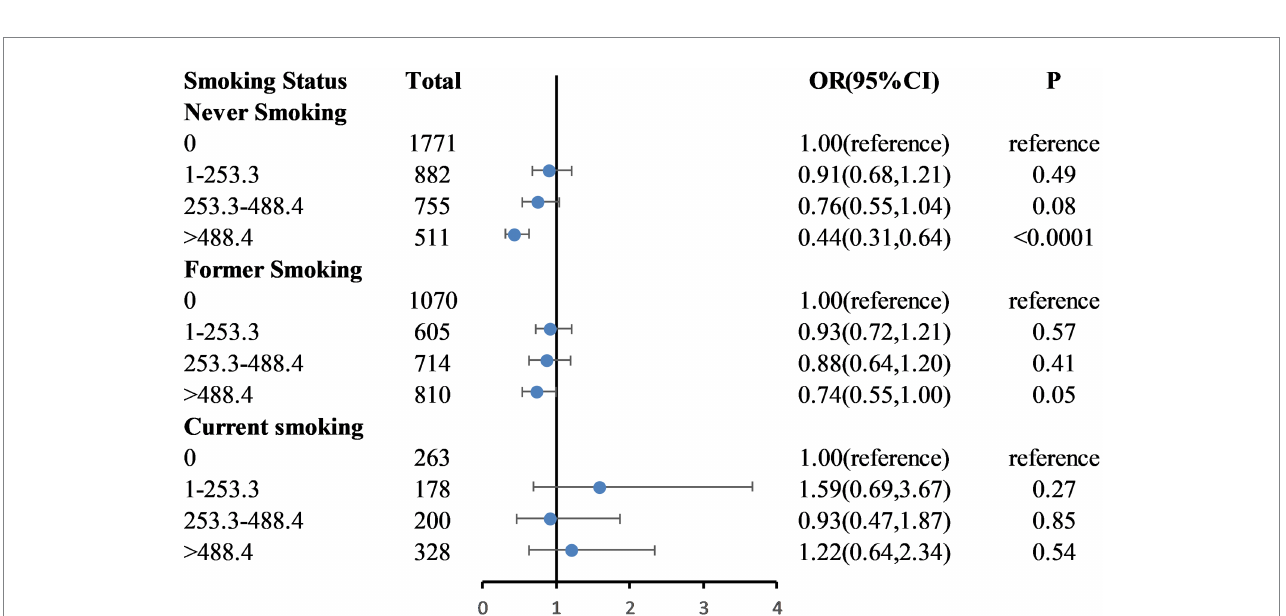
FIGURE 3 Weighted odds ratios (95% confidence intervals) for the association between caffeinated coffee and frailty by smoking status subgroups. The multivariable model is age, sex, ethnicity, educational level, marital status, poverty-to-income ratio, BMI, total energy intake, hypertension, diabetes, coronary heart disease, stroke, and physical